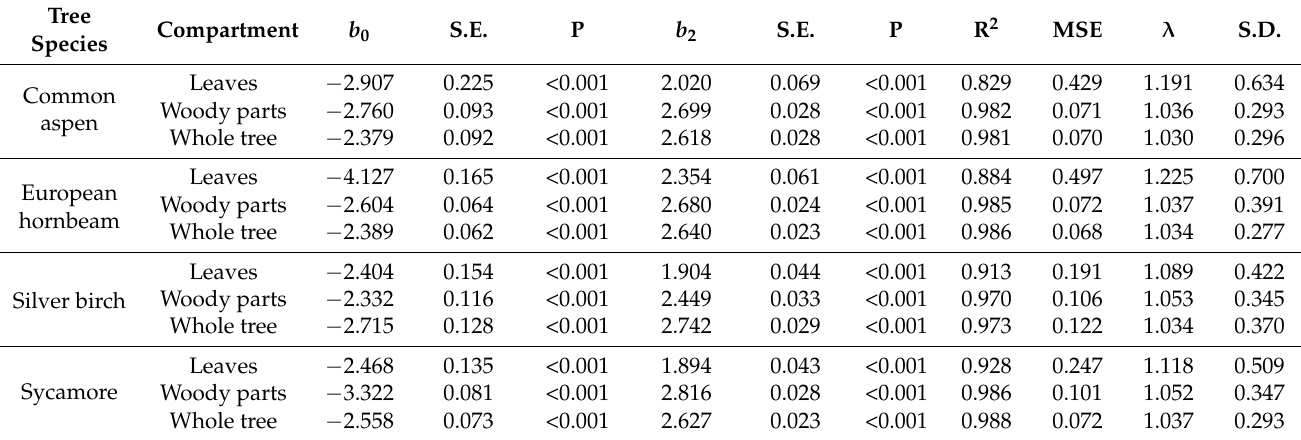
Table 3. Species-specific biomass models for leaves, woody parts (i.e., branches, stem and roots) and a whole tree based on Equation (2) with diameter at stem base d 0 as a predictor. λ is logarithmic transformation bias, and the meaning of other abbreviations is explained in Table 1.